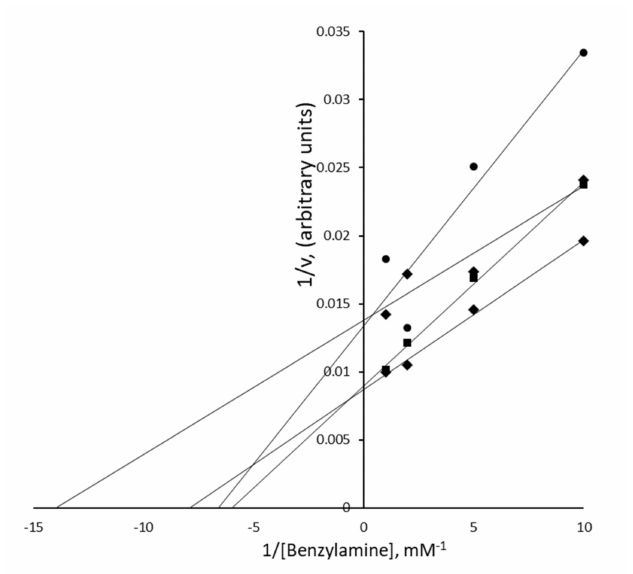
Figure 4. Inhibition of hScAT PrAO by theobromine. The concentration of benzylamine varied between 0.1 and 1.0 mM in the presence of increasing concentrations of theobromine: 0, 0.1, 1.0 and 2.5 mM. The concentration of theobromine used were: 0 mM (diamonds), 0.1 mM (squares), 1.0 mM (diamonds), and 2.5 mM